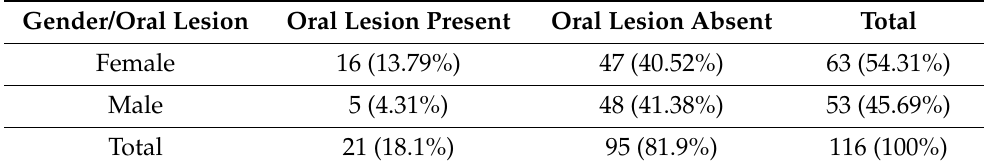
Table 2. The distribution of lesions according to gender.